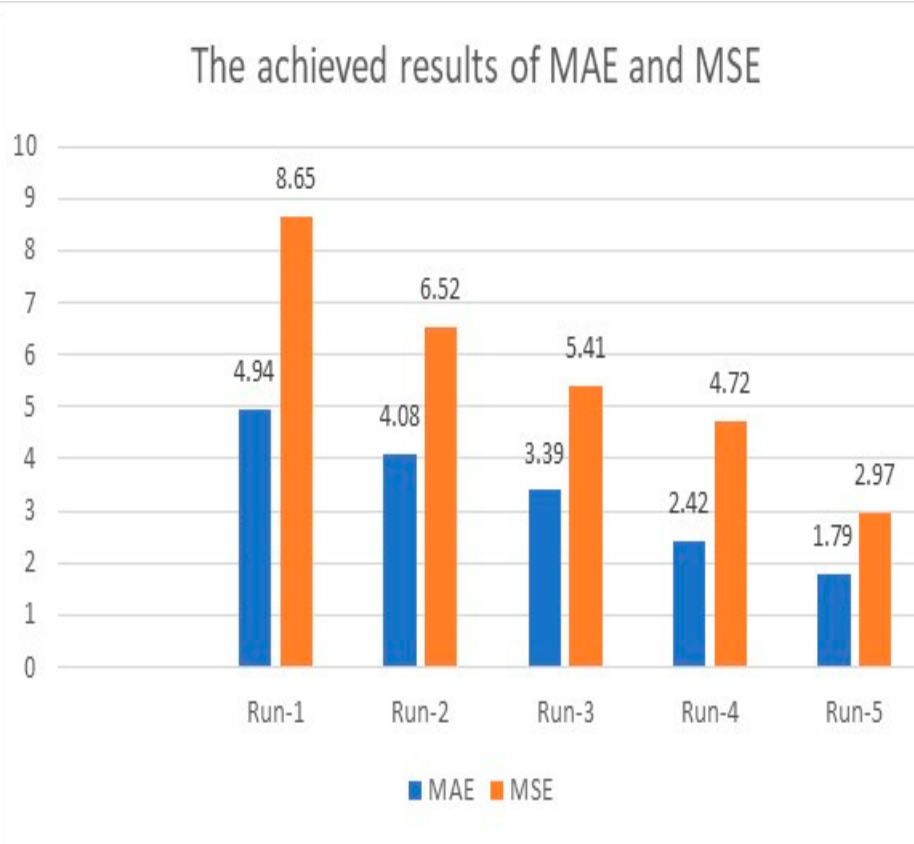
Table 5. The comparative analysis results. Works